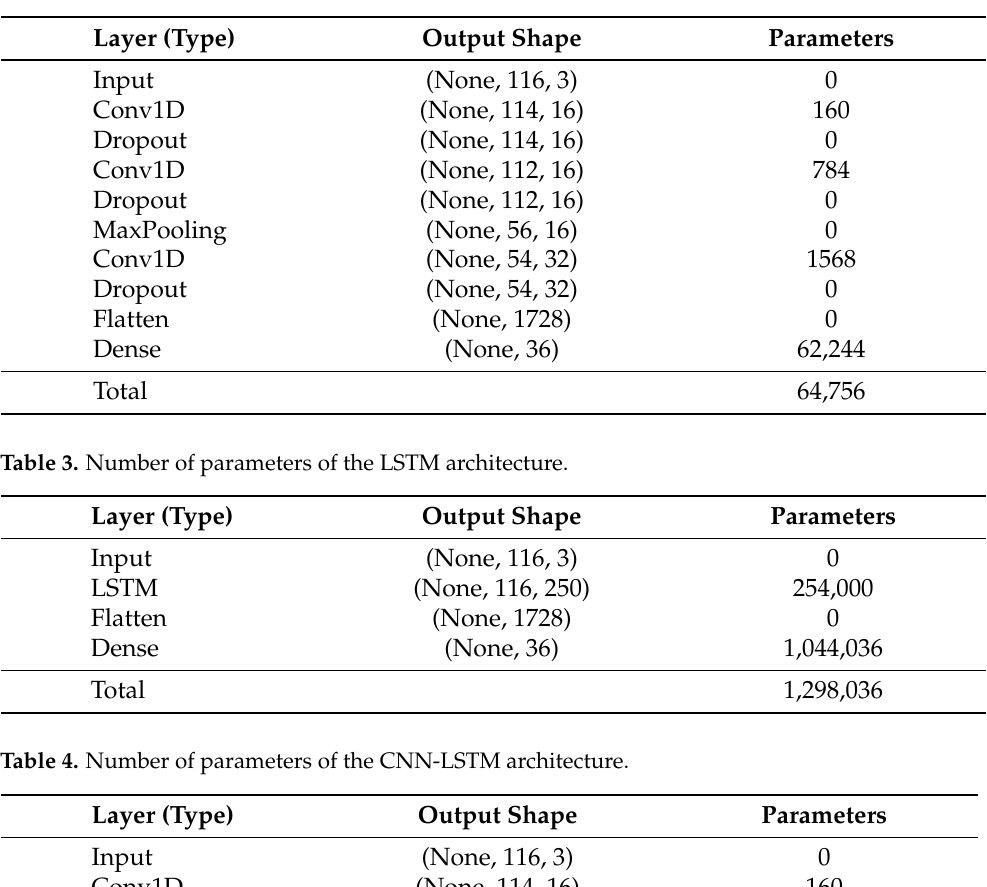
Table 2. Number of parameters of the CNN architecture.